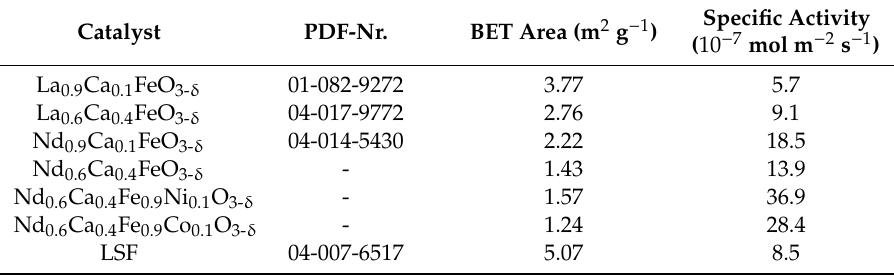
Table 1. PDF-numbers of the reference structures used in Figure 1, BET surface areas of the di ff erent perovskite materials and average specific activities calculated for CO 2 production during high temperature water–gas shift (HT-WGS) at 600 ◦